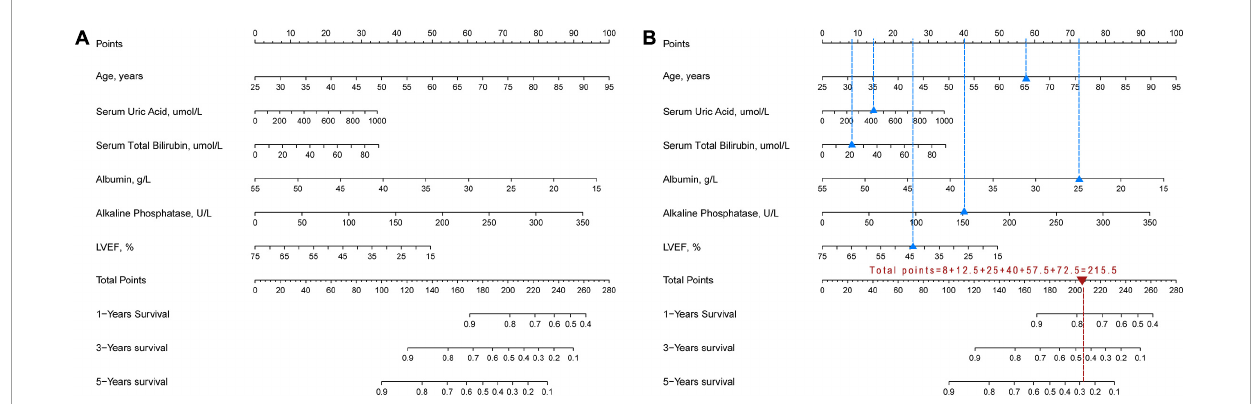
FIGURE3 Nomogram for assessing the risk of death within 1, 3, 5 years in IHD patients. (A) Complete nomogram. (B) How to use the nomogram. Blue triangles show clinical indicators for a hypothetical IHD patient and blue dashed lines show the corresponding scores. Red triangles show the total scores and the red dashed lines show the corresponding survival rates.